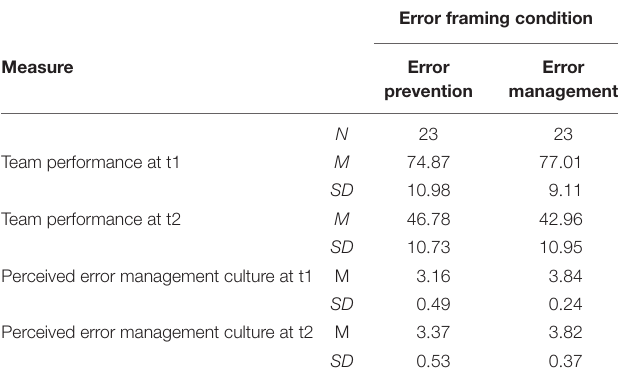
TABLE 2 | Means and standard deviations of dependent and process variables in Study 1 by between-participants factor